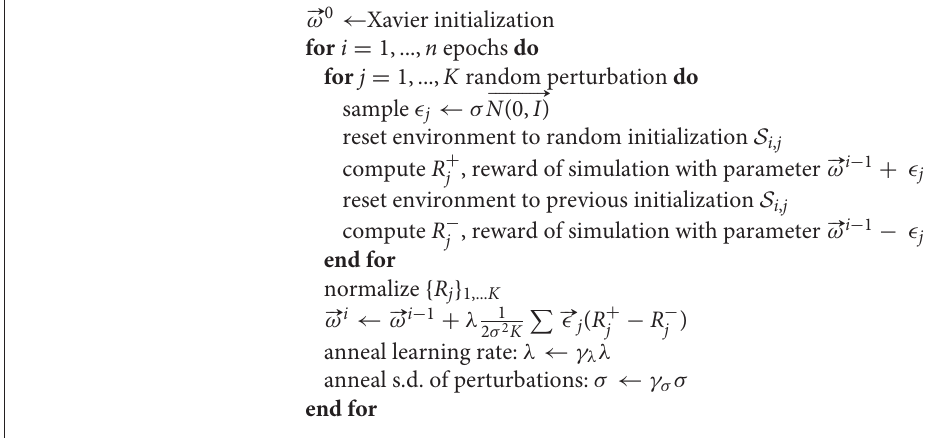
FIGURE 4 | Evolution strategies algorithm.